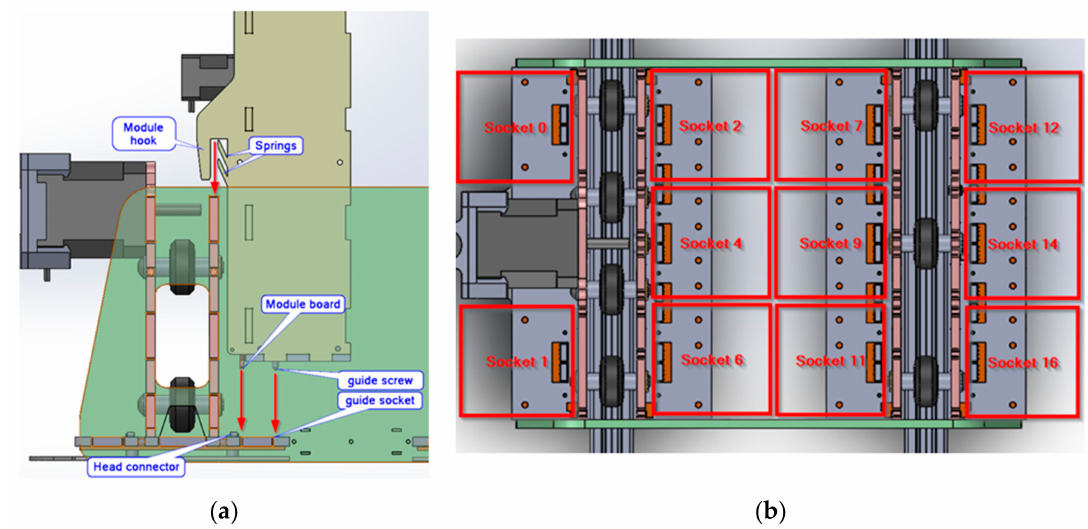
Figure 4. Head of the actuation layer. ( a ) Mechanism to plug a module on the head, which automatically produces an electrical connection between the electronics of the module and the main controller. ( b ) Sockets of the head, which can have eleven modules connected at the same time.